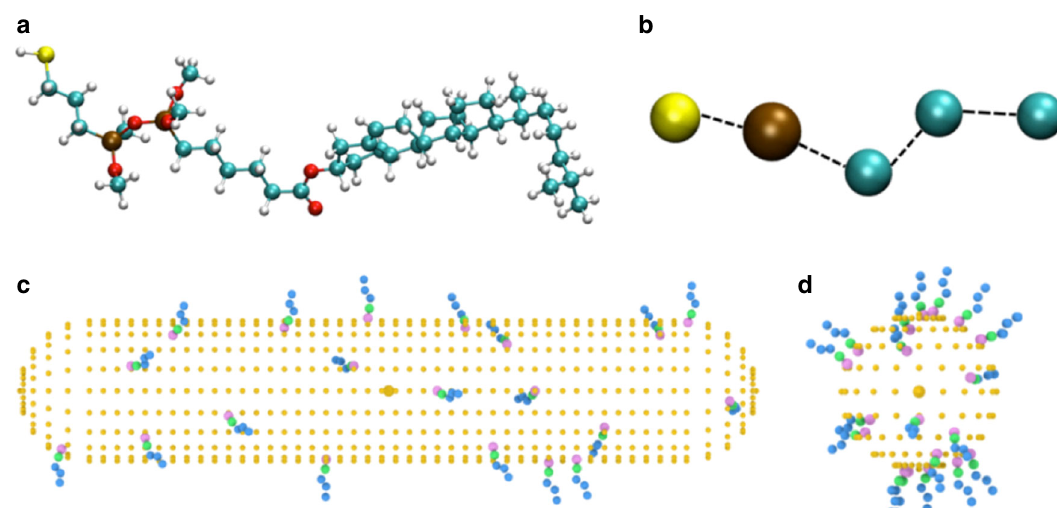
Fig. 8 Atomistic and coarse-grained representation of the Chol-silane molecule. a Full representation of a chiral ligand molecule. b Coarse-grained description of the same ligand molecule, where only 5 of the original 118 atoms were retained: one Si, one S and three C atoms. c GNR1 spherocylindrical nanoparticle decorated with 20 CG Chol-silane ligands randomly distributed. d NP3 quasi-spherical Au nanoparticle bound to the same number of Chol- silane molecules in the Coarse Grained